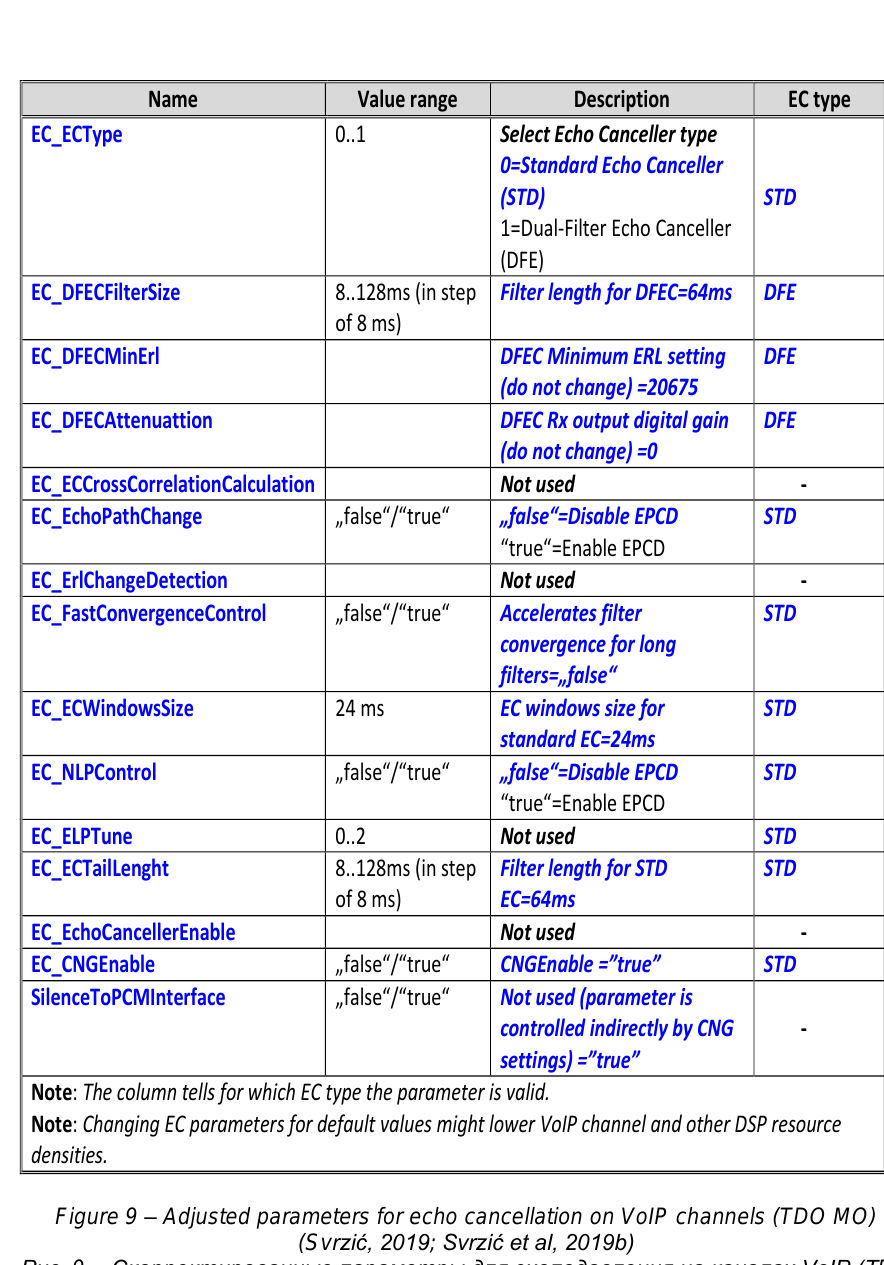
Figure 9 – Adjusted parameters for echo cancellation on VoIP channels (TDO MO) (Svrzić, 2019; Svrzić et al, 2019b) Рис. 9 – Скорректированные параметры для эхоподавления на каналах VoIP (ТDO MO) (Svrzić, 2019; Svrzić et al, 2019b) Слика 9 – Подешени параметри за потискивање еха на VoIP каналима (TDO MO) (Svrzić, 2019; Svrzić et al,